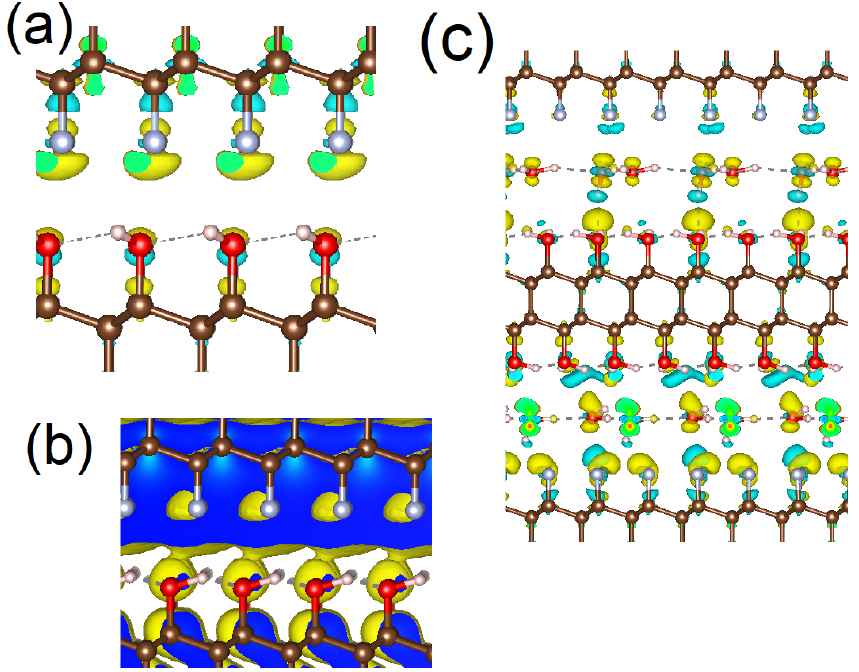
Figure 2. Changes in charge density after formation of C 2 F/C 2 OH interface ( a ), the sequence charge density of conductive band minimum orbitals of C 2 F and C 2 OH in C 2 F/C 2 OH interface ( b ), and changes in charge density after formation of multilayered water–C 2 F–water–C 2 OH–water structure ( c ). Cyan and yellow clouds corresponding with decreasing and increasing charge density. The color scale of the atoms is the same as in Figure 1.